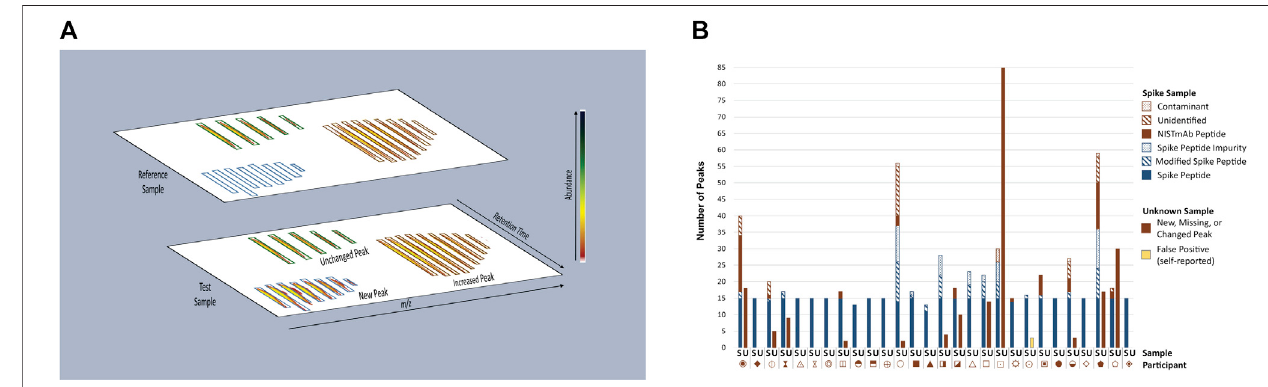
FIGURE 2 | Overview of MAM New Peak Detection Data Analysis. (A) A representation of new peak detection data is shown for a single charge state/isotope cluster for a new peak, changed peak, and unchanged peak (B) Peaks Reported as New, Missing, or Changed in Spike and Unknown Samples. New, missing, and changed peaks detected in the Spike (S) and Unknown (U) Samples were reported by each participant. For the Spike Sample, peaks that conformed to expectation are represented in blue: Spike Peptides, Modi fi ed Spike Peptides ( e.g., Spike Peptide with a PTM) and Spike Peptide Impurities ( e.g., Spike Peptide with additional residue,truncation,etc.);peaksthatdidnotconformtoexpectationarerepresentedinred:NISTmAbPeptides,Unidenti fi edPeaks,Contaminants.Peaksdetectedinthe Unknown Sampledid notconform toexpectation andarerepresentedinred withoutfurther categorization. Oneparticipantself-reported peaksinthe Unknown Sample asfalsepositives(representedinyellow)andthuswerecountedasaconformingresult.Eachparticipantisrepresentedbyauniquesymbol.This fi gurewasadaptedfrom Mouchahoir et al., 2021 (https://pubs.acs.org/doi/10.1021/jasms.0c00415), with permission from ACS Publications; further permissions related to this material should be directed to